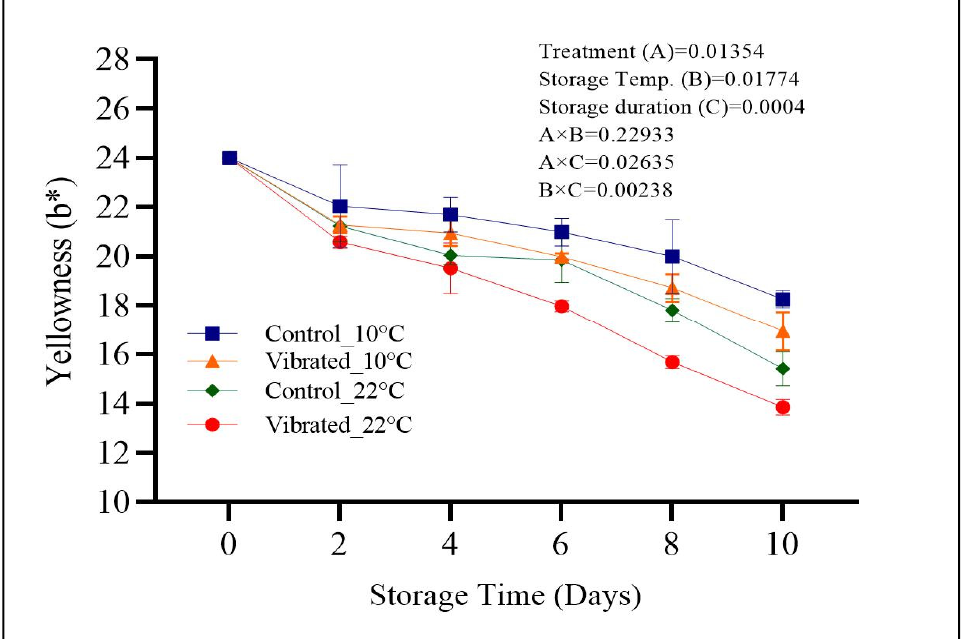
Figure 7. Yellowness (b*) value of vibrated and non-vibrated (control) tomatoes stored at 10 °C and 22 °C for 10 days storage. Error bars represent the standard deviation (SD) of the mean values ± S.D 15 readings per 3 replicates.